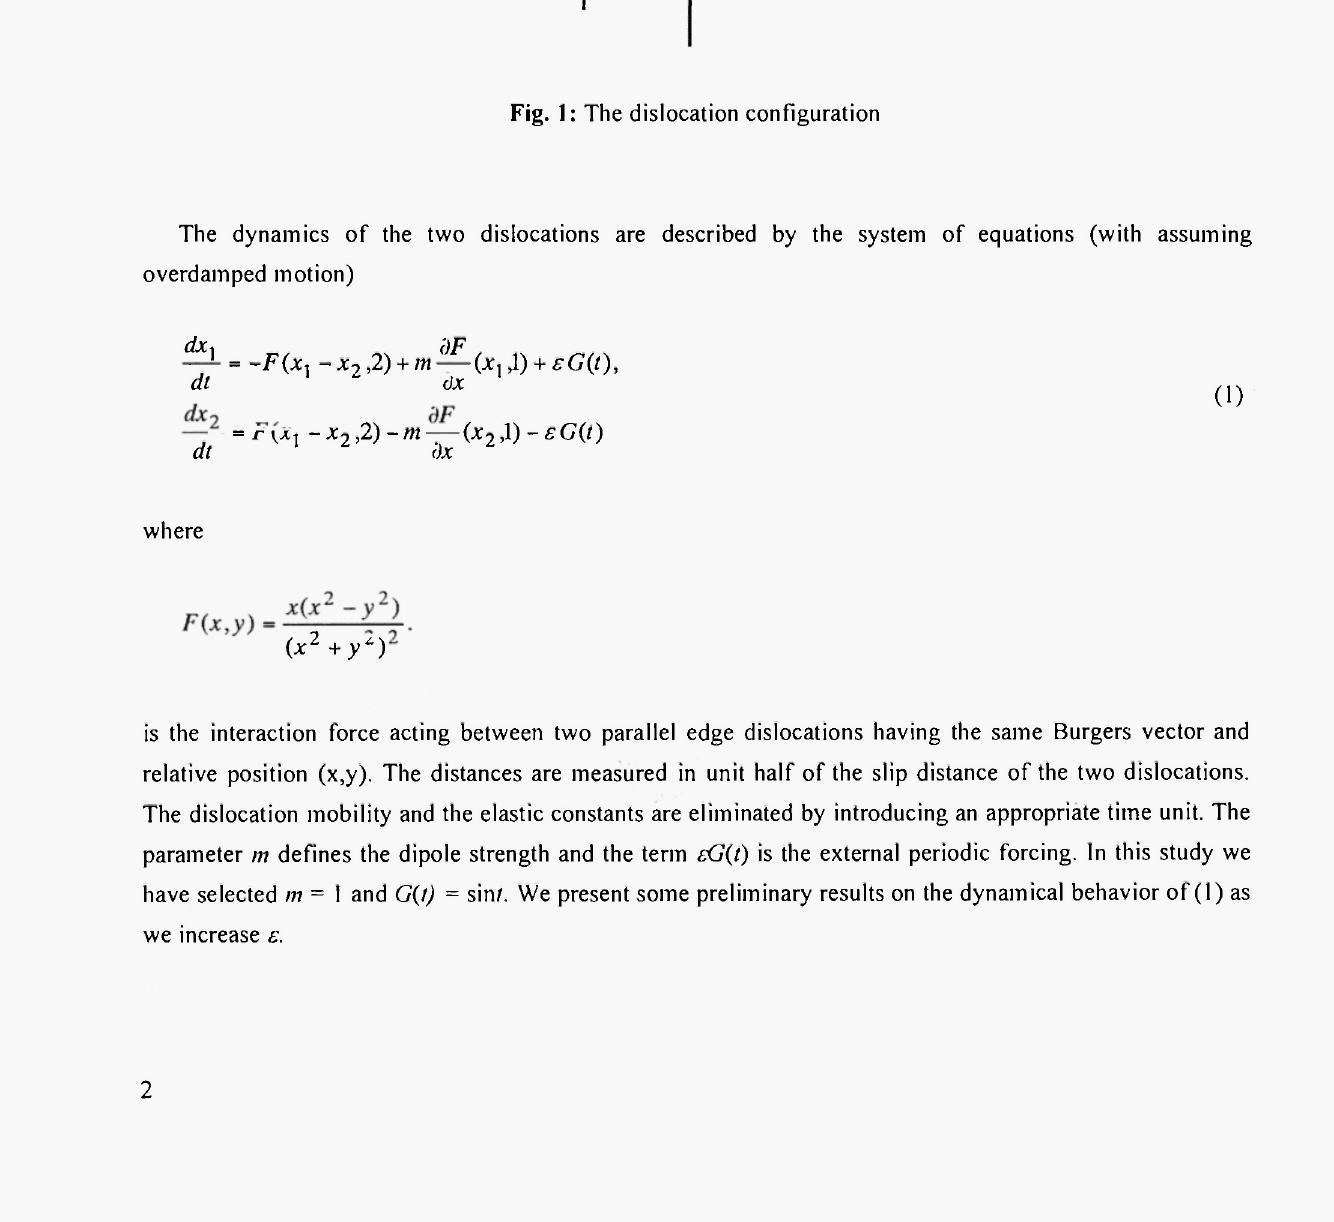
Fig. 1: The dislocation